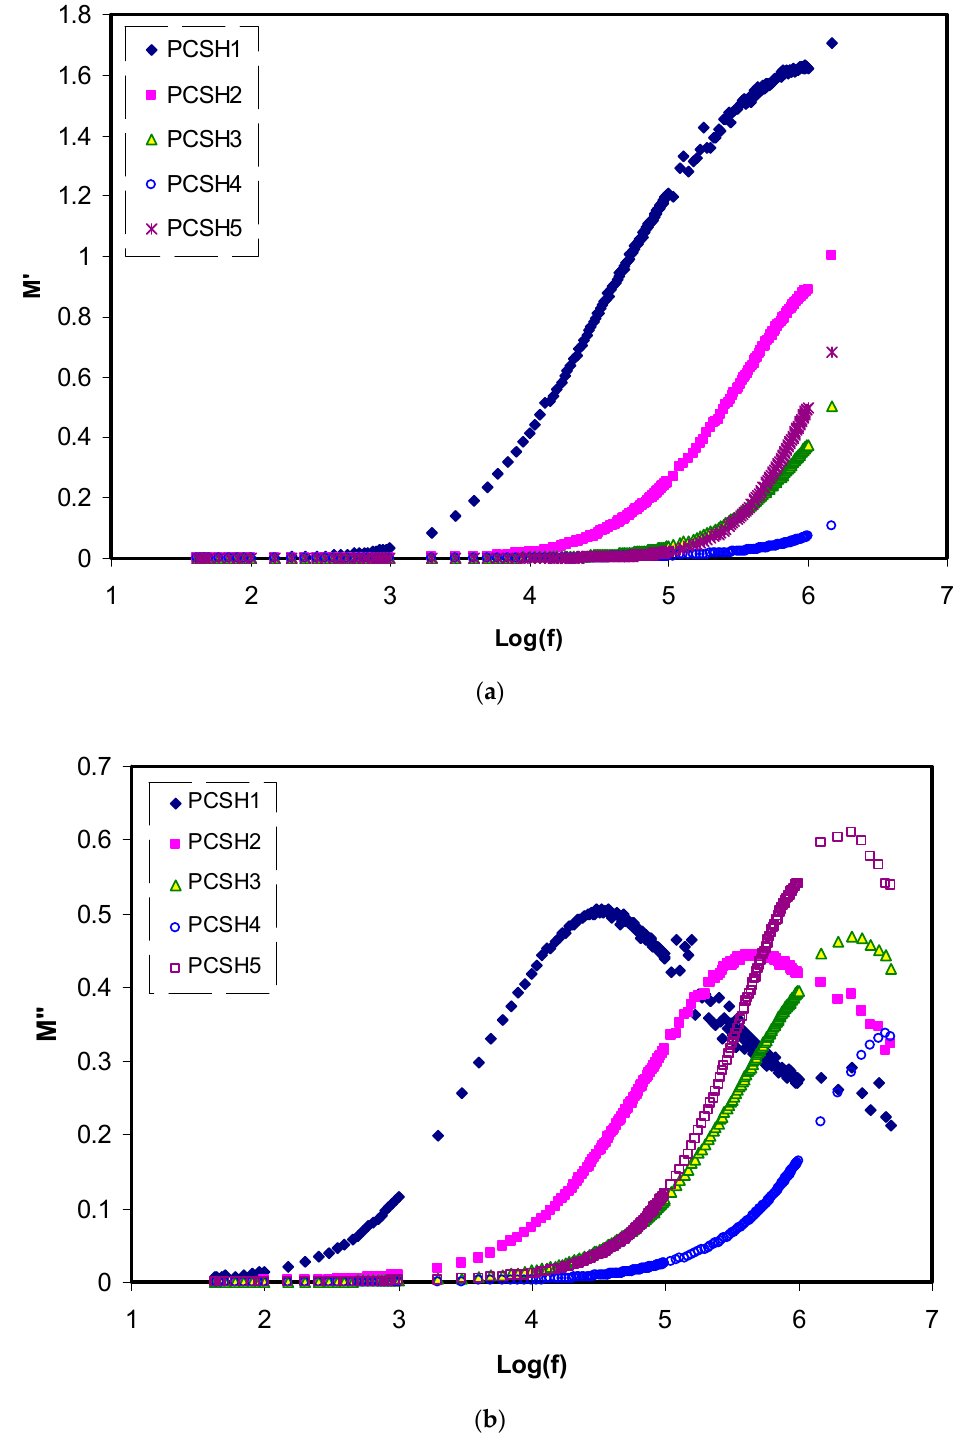
Figure 5. Variation of ( a ) real part of electric modulus (M r ) and ( b ) imaginary part of electric modulus (M i ) versus frequency for the polymer blend electrolyte systems at room temperature.